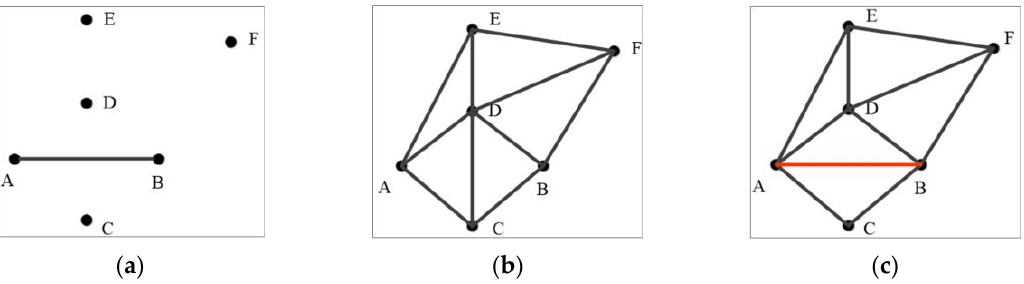
Figure 3. Delaunay triangulation constrained by nodes and segments. ( a ) Input nodes and segments, ( b ) triangulation with nodes without segment AB, and ( c ) CDT with nodes and segment AB.